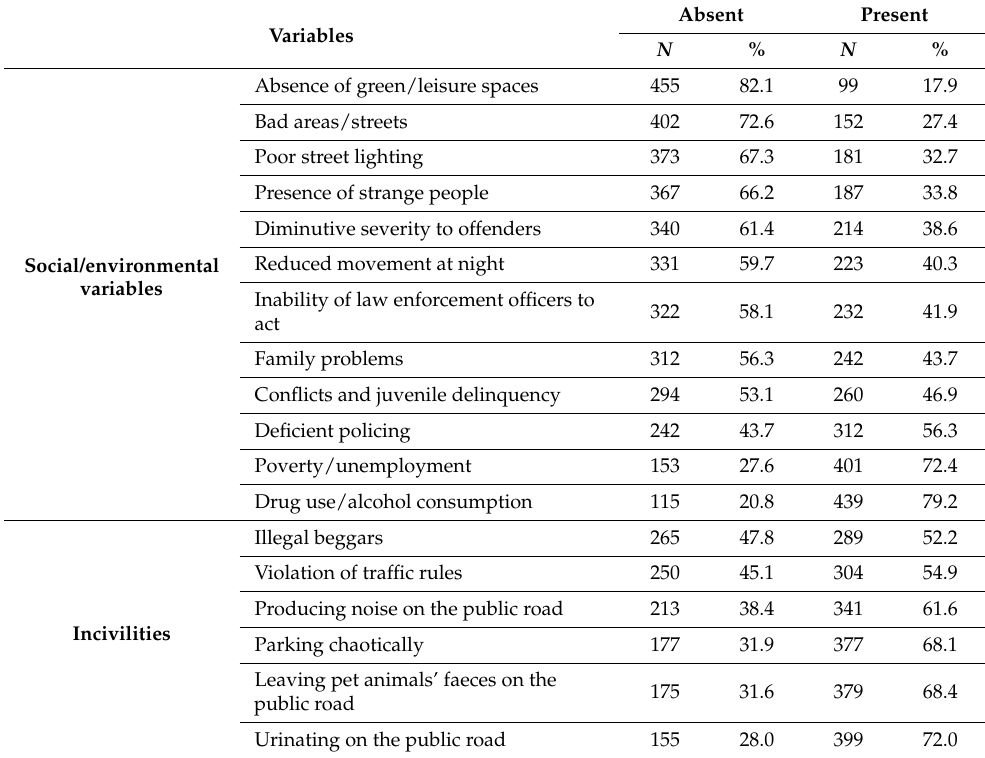
Table 1. Frequencies and percentages of the social/environmental variables and incivilities